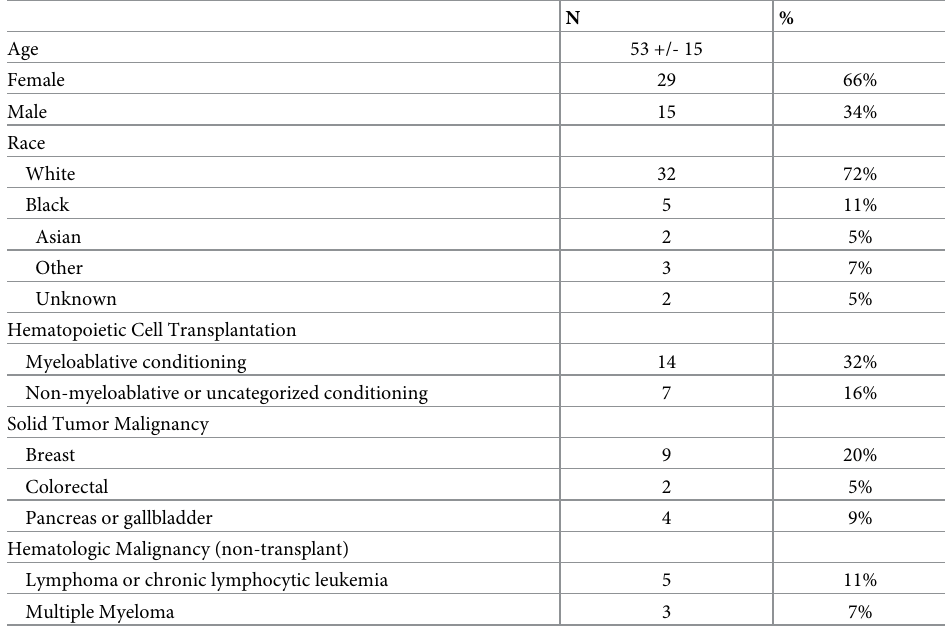
Table 1. Study Cohort Descriptive Data (N =